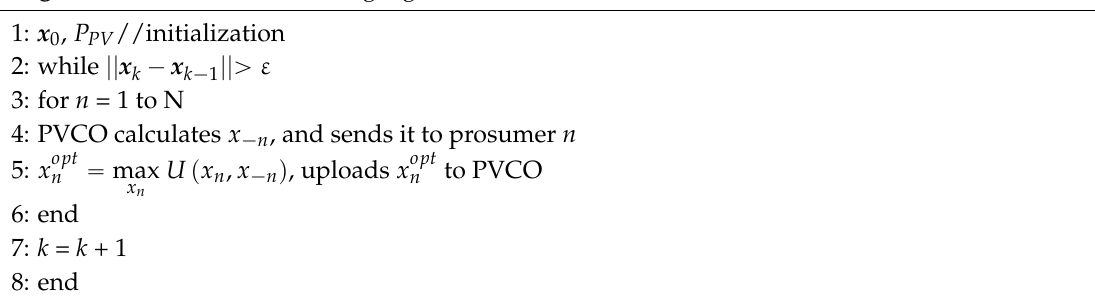
Algorithm 1. Distributed solving